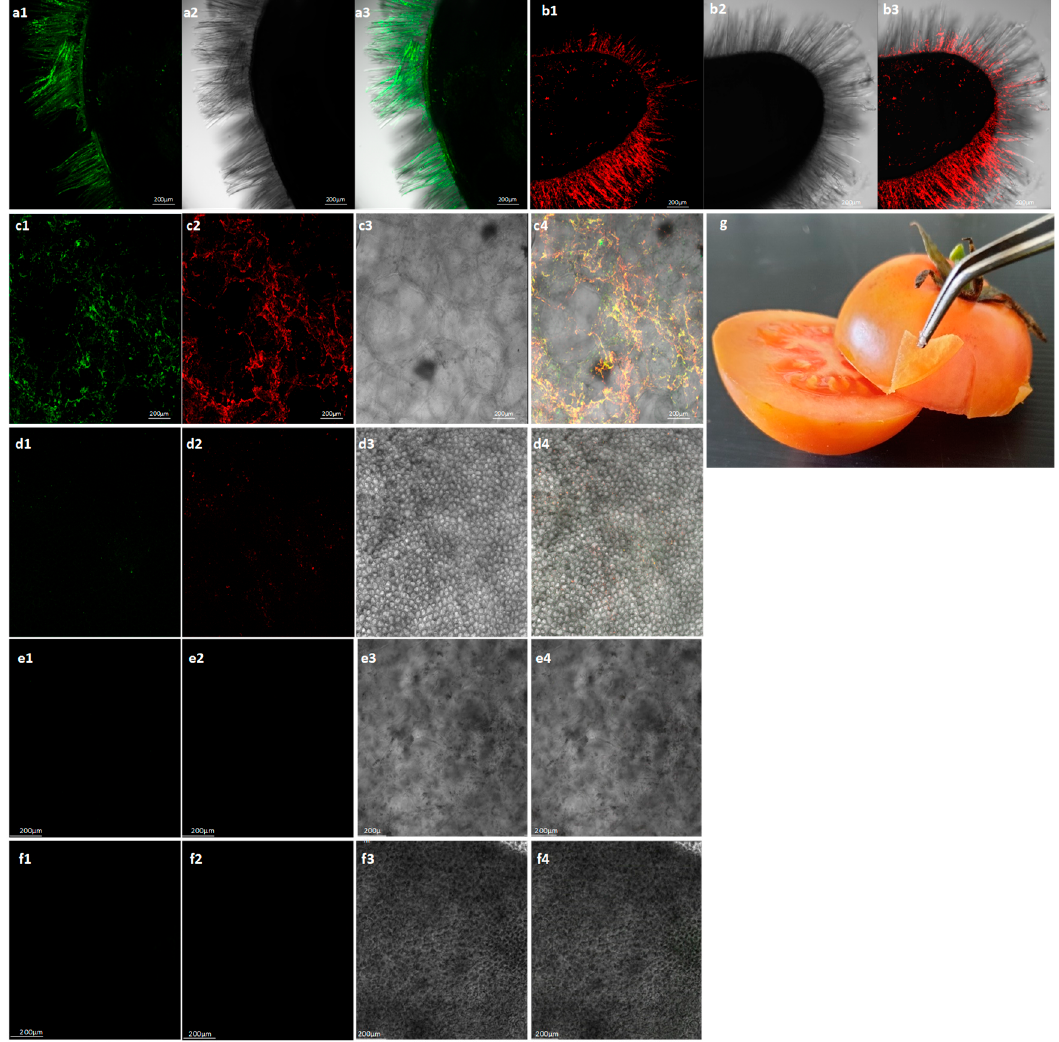
Figure 2. In situ immunofluorescence localization of tomato brown rugose fruit virus (ToBRFV) and pepino mosaic virus (PepMV) in symptomatic tomatoes. ( a1 ) ToBRFV coat protein (CP) detection in infected tomato seeds using antibodies conjugated to Alexa 488, visualized with green channel; ( a2 ) ToBRFV-infected tomato seeds visualized using bright field; ( a3 ) ToBRFV-infected tomato seeds visualized by merging channels; ( b1 ) PepMV CP detection in tomato seeds using antibodies conjugated to Alexa 594, visualized with red channel; ( b2 ) PepMV-infected tomato seeds visualized using bright field; ( b3 ) PepMV-infected tomato seeds visualized by merging channels; ( c1 ) ToBRFV-CP detection in co-infected tomato exocarp, facing the mesocarp, using the green channel; ( c2 ) PepMV-CP detection in the co-infected tomato exocarp, facing the mesocarp, using the red channel; ( c3 ) co-infected tomato exocarp, facing the mesocarp, visualized using bright field; ( c4 ) ToBRFV and PepMV detection in co-infected tomato exocarp, facing the mesocarp, using merged channels; ( d1 ) ToBRFV-CP detection in co-infected tomato exocarp surface using the green channel; ( d2 ) PepMV-CP detection in co-infected tomato exocarp surface using the red channel; ( d3 ) Co-infected tomato exocarp surface visualized using bright field; ( d4 ) Exocarp surface from a co-infected tomato visualized using merged channels; ( e , f ) Exocarp dissected from a control healthy tomato subjected to immunofluorescence. ( e1 ) Imaging of exocarp facing the mesocarp using the green channel; ( e2 ) Imaging of exocarp facing the mesocarp using the red channel; ( e3 ) Imaging of exocarp facing the mesocarp using bright field; ( e4 ) Imaging of exocarp facing the mesocarp using merged channels; ( f1 ) Imaging of exocarp surface using the green channel; ( f2 ) Imaging of exocarp surface using the red channel; ( f3 ) Imaging of exocarp surface using bright field; ( f4 ) Imaging of exocarp surface using merged channels; ( g ) Exocarp dissection from a co-infected tomato fruit.